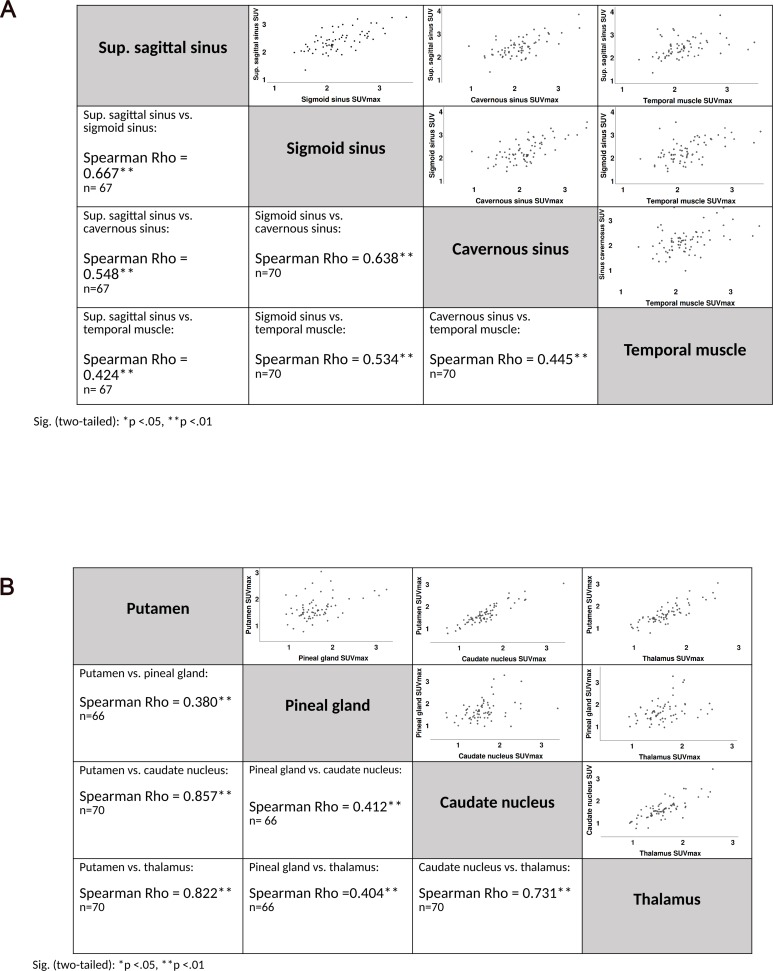
Intra-cluster correlations.A Intra-cluster correlations of the venous cluster vary between 0.42 and 0.67, all highly significant. B Intra-cluster correlations of the deep gray matter cluster vary between 0.38 and 0.82, all highly significant. Sig. (two-tailed): **p < .01. Spearman Rho rank correlation applicable for non-parametric distribution in the scatter plot. Strength of correlation < 0.3 = no correlation, 0.3–0.5 weak, 0.5–0.8 moderate, > 0.8 strong correlation [30].